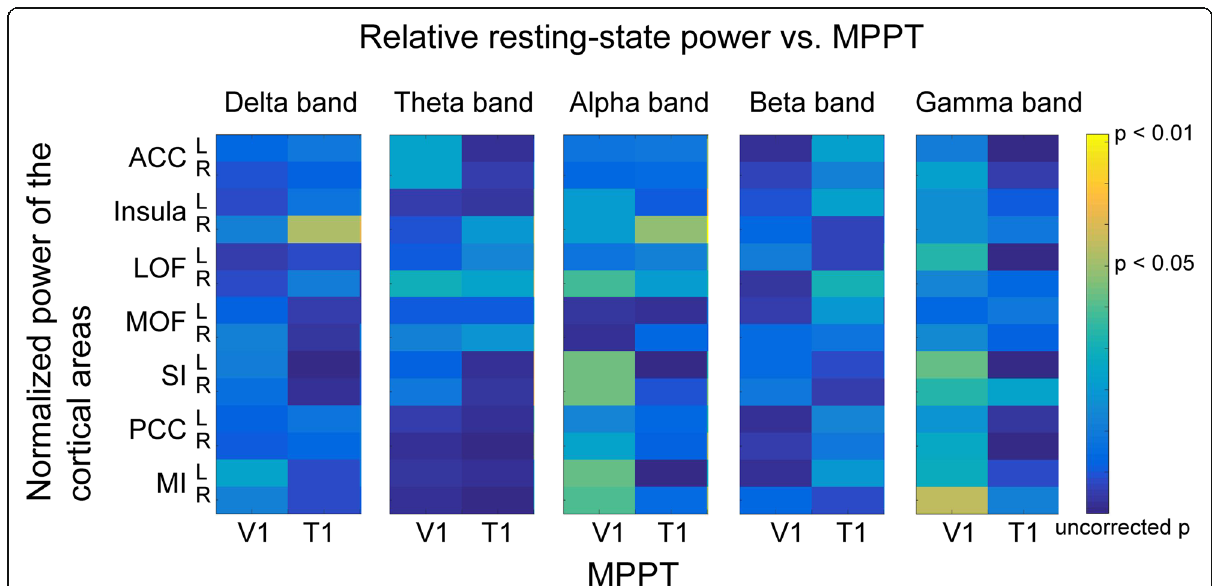
Fig. 5 In patients with episodic migraine, no correlation between the mechanical punctate pain threshold and relative resting-state power. MPPT, mechanical punctate pain threshold; ACC, anterior cingulate cortex; LOF, lateral orbitofrontal cortex; MOF, medial orbitofrontal cortex; SI, primary somatosensory cortex; PCC, posterior cingulate cortex; MI, primary motor cortex; V1, left supraorbital (the first branch of the trigeminal nerve dermatome); T1, proximal medio-ventral forearm (the first thoracic nerve